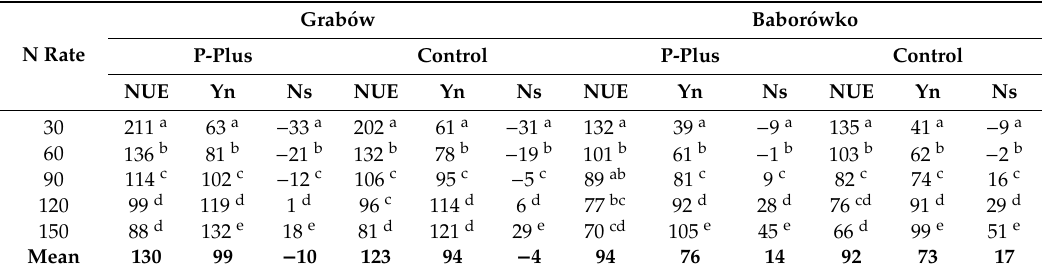
The small letters denote di ff erence between NUE, Yn, Ns in P-plus and control treatments in the same location; Treatments with the same letter are not significantly di ff erent ( p ≤ 0.05); n = 320 for each location. Table 8. N use indices for spring barley; N fertilizer rate, Yn (uptake), Ns (surplus) (kg · ha − 1 ); NUE (%) for the P fertilizer addition (P-plus) and control (no P